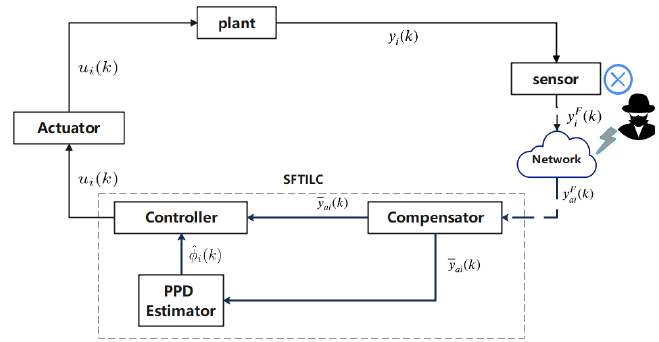
Figure 1. System block